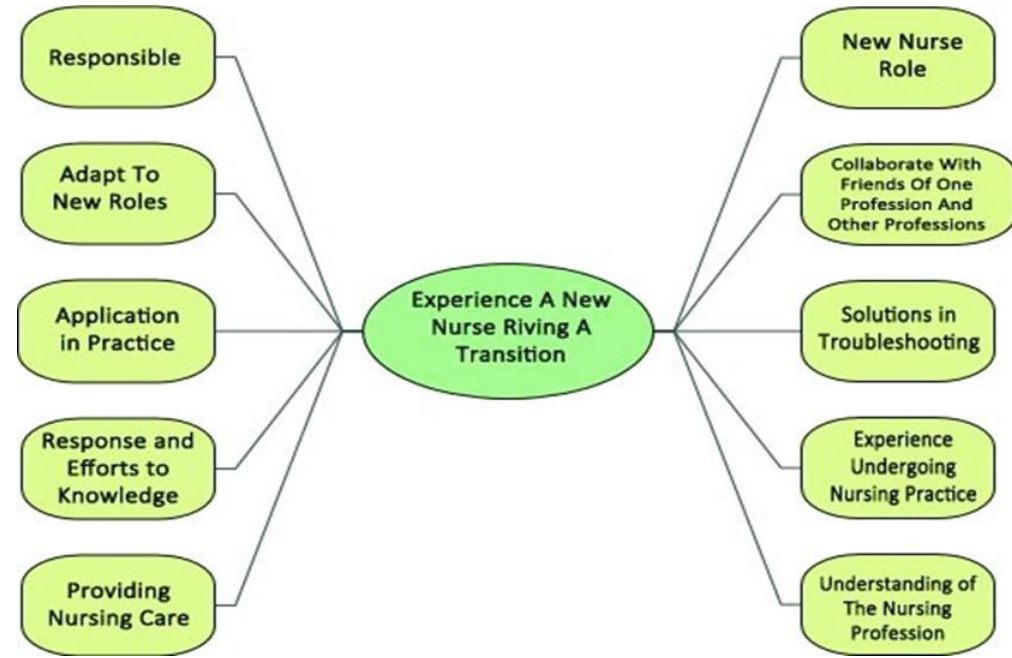
Fig. 4. Themes and sub-themes of experiences in transition